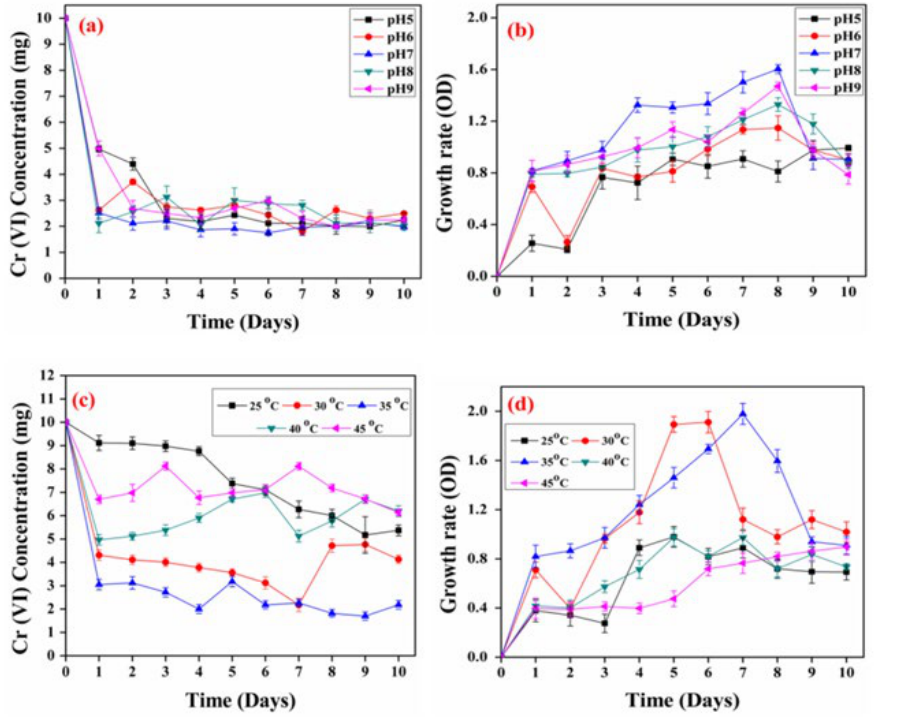
Fig. 5. Influence of various pH and temperatures on reduction of hexavalent